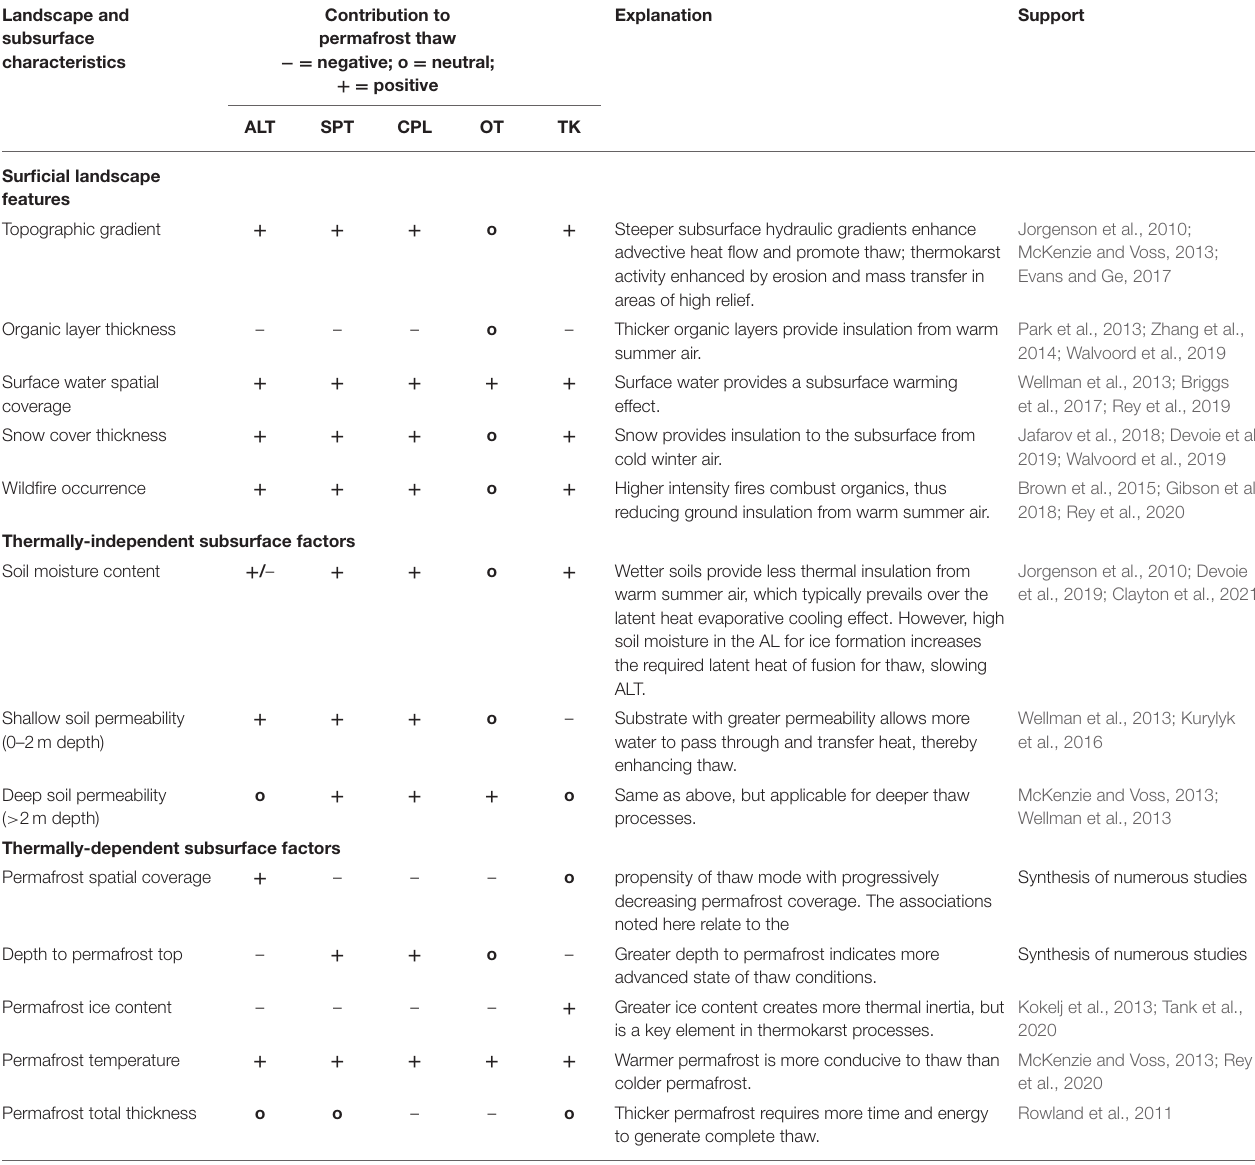
TABLE 1 | Influence of landscape and subsurface characteristics on permafrost thaw vulnerability to each primary mode of thaw. Landscape and